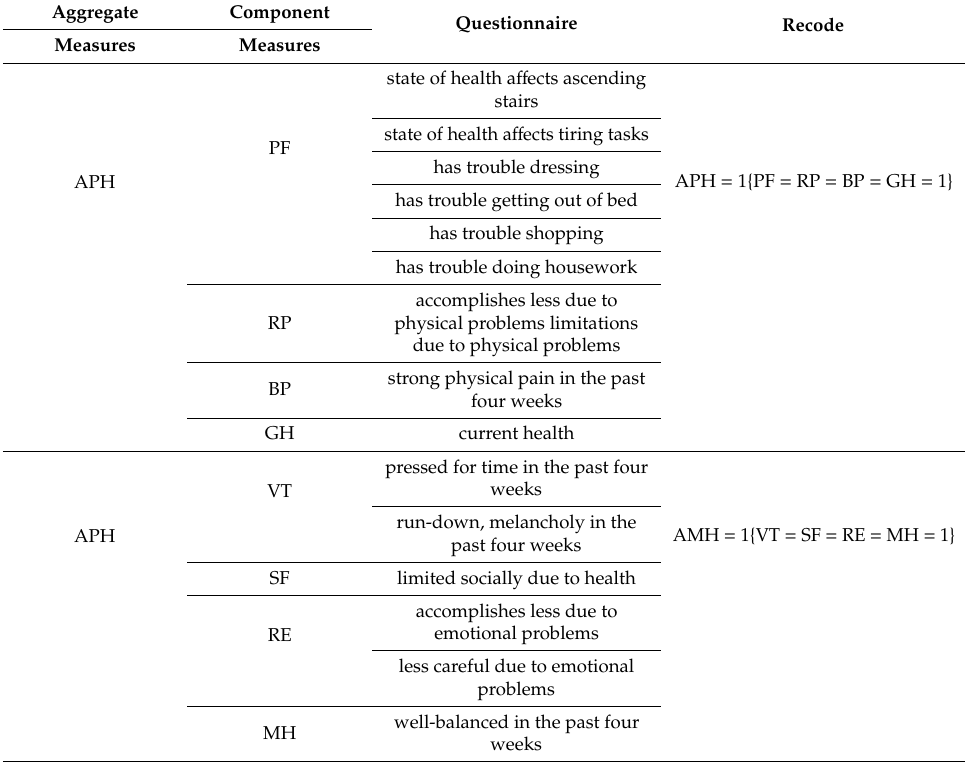
Table 1. Questionnaire of each component